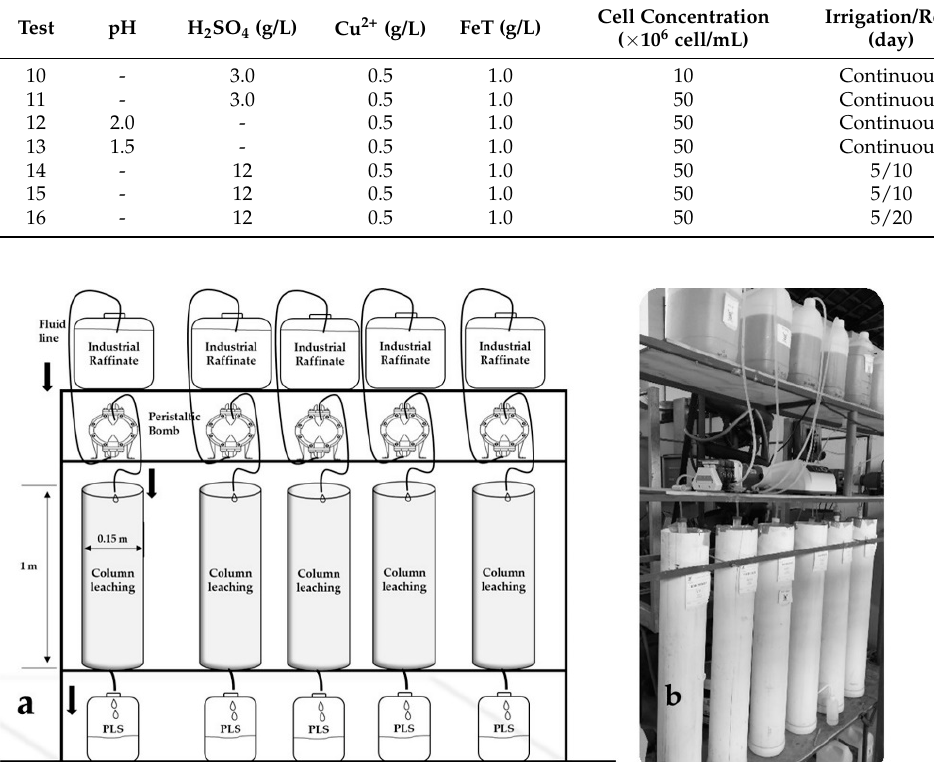
Table 4. List of tests performed on the chalcopyrite ore using columns 1.0 m in height.